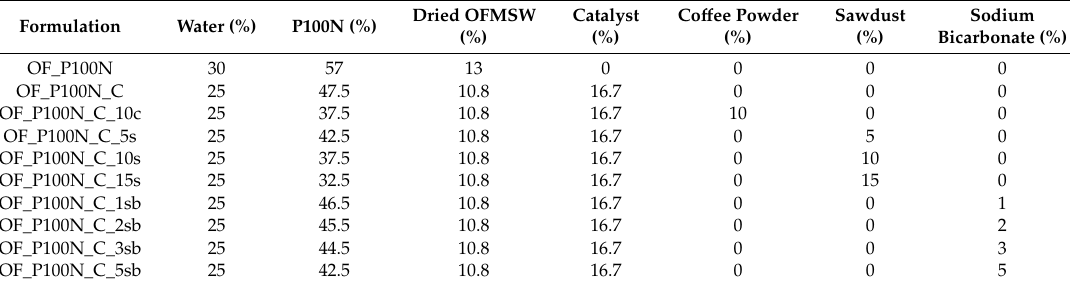
Table 1. Weight composition of